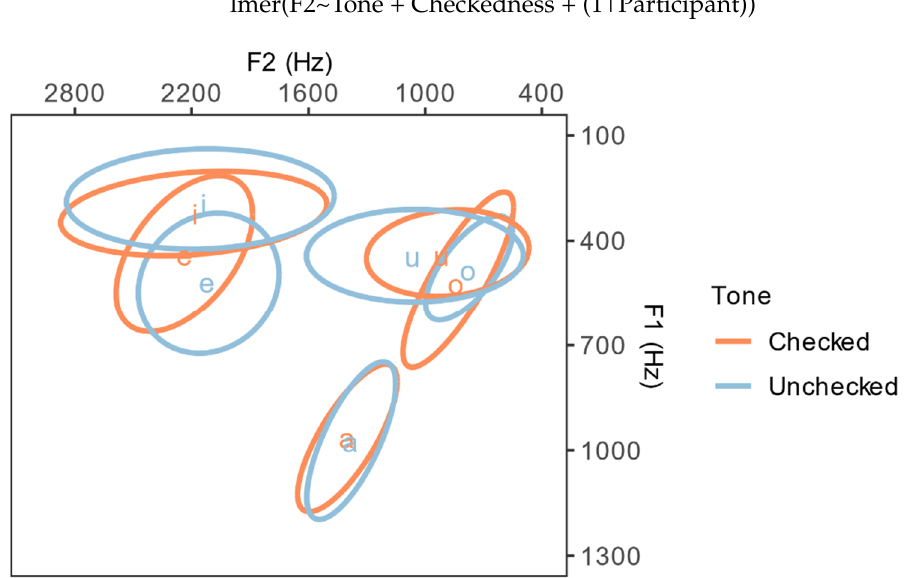
Figure 9. F1 and F2 distribution of vowels in checked and unchecked tones.